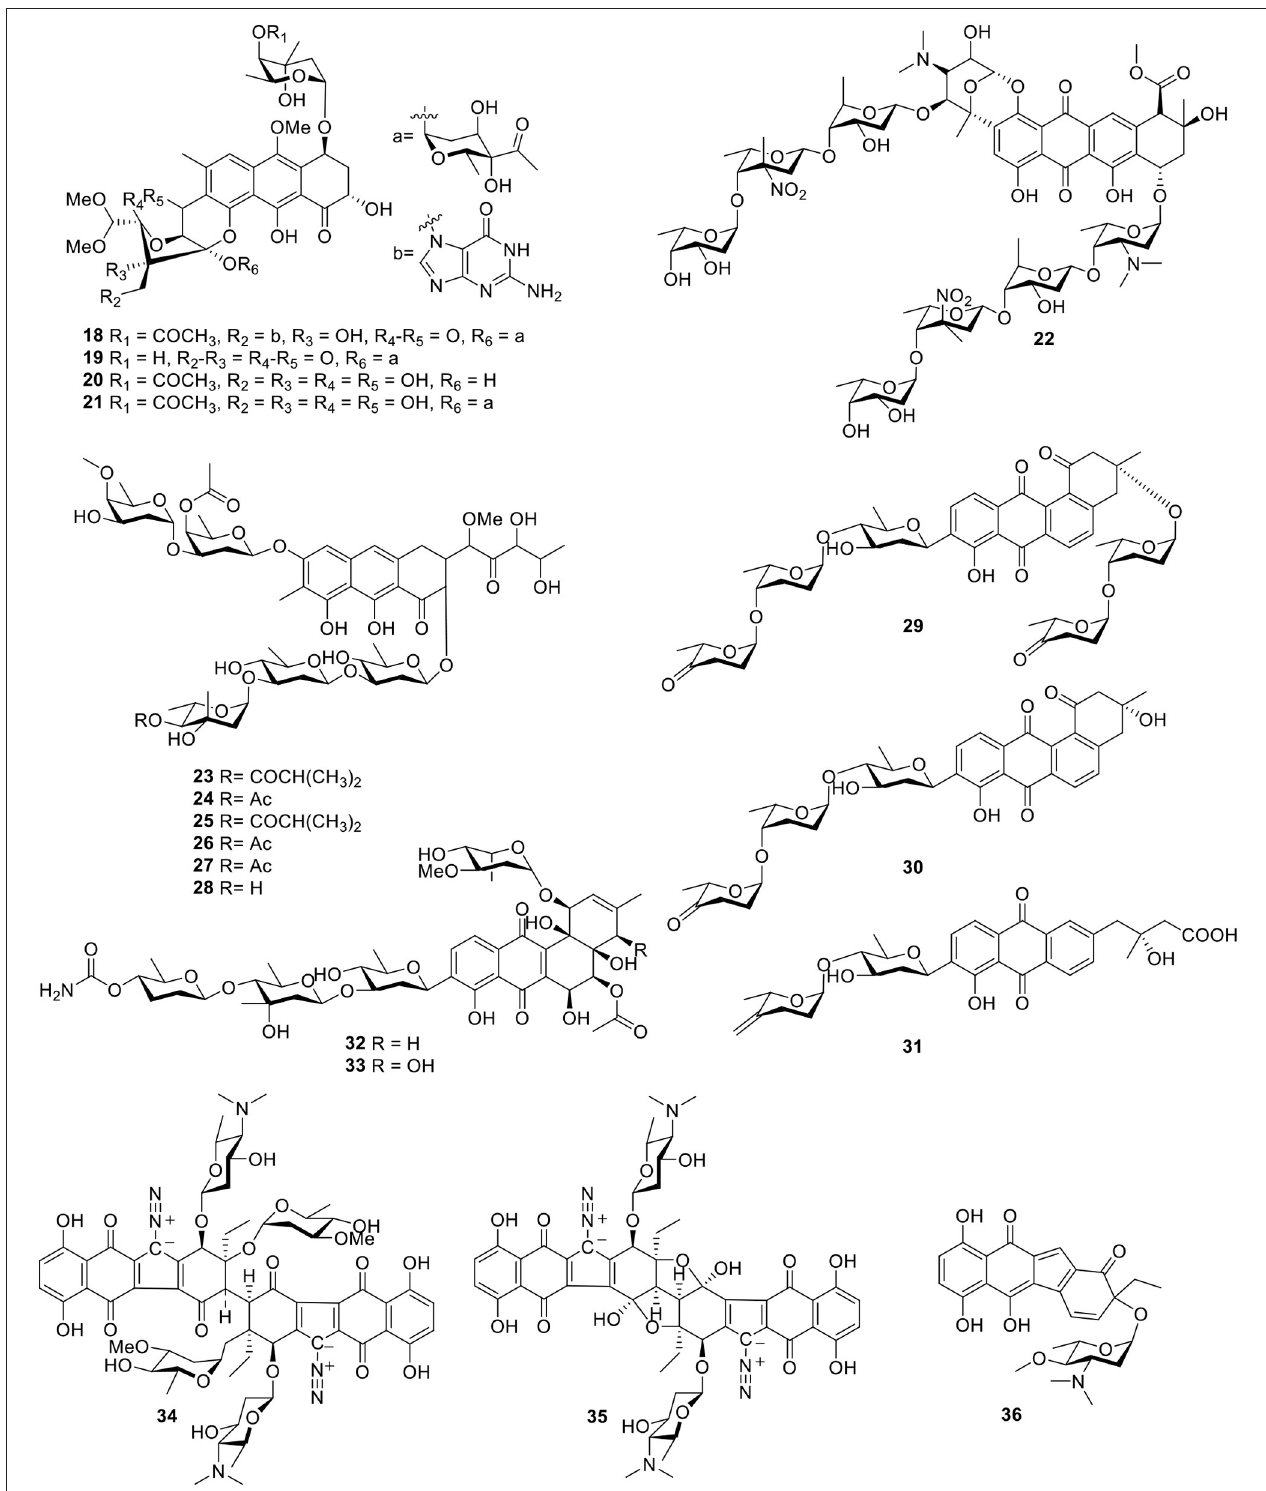
FIGURE 3 | Chemical structures of compounds 18–36 derived from marine-sourced bacteria.